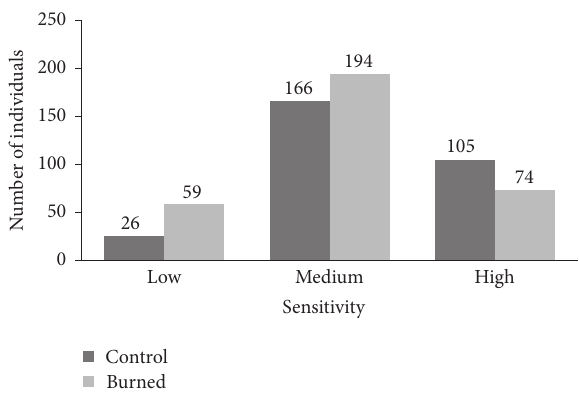
Figure 6: Distribution of the bird fauna of the control and burned plots in eastern Acre, Brazil, according to the sensitivity of the different species to habitat disturbance. Table 3: Vegetation structure: number of bamboo stems, palms, and dead trees in the study plots in eastern Acre, Brazil. The dead trees wereclassifiedaccordingtotheirdegreeofdecomposition(ST1,ST2, and ST3).